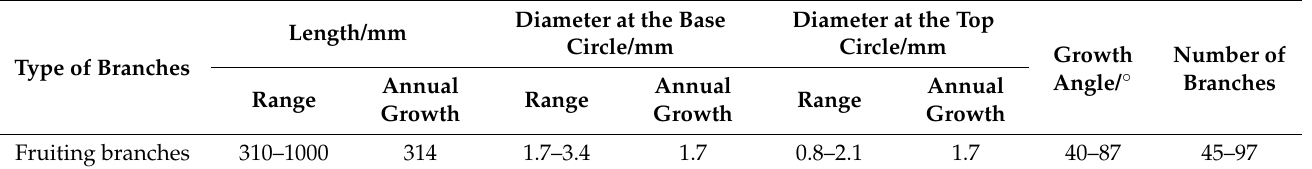
Table 3. Length, growth angle, and diameter of